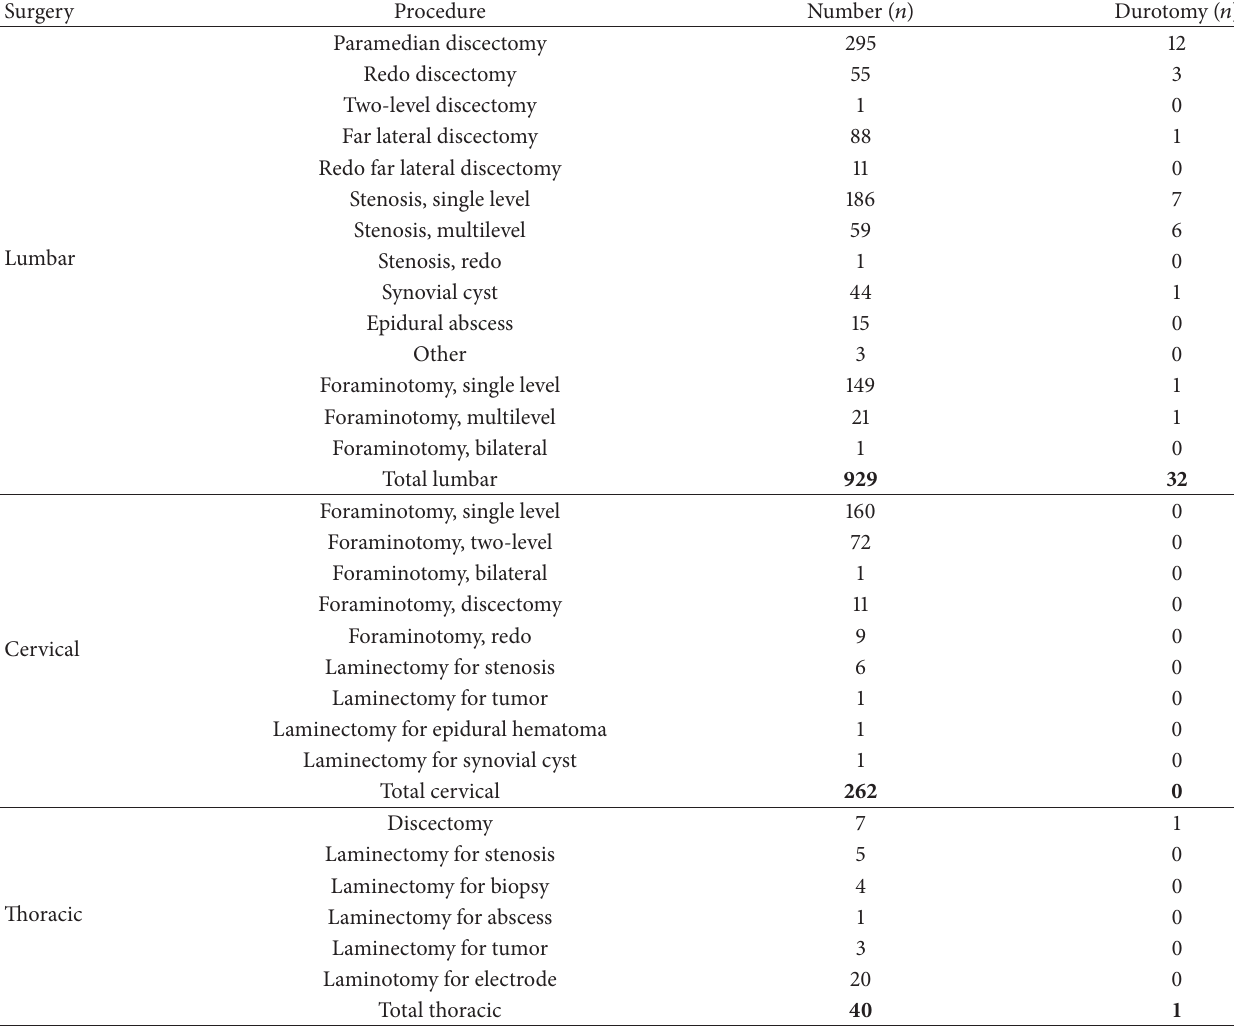
Table 1: Surgical case